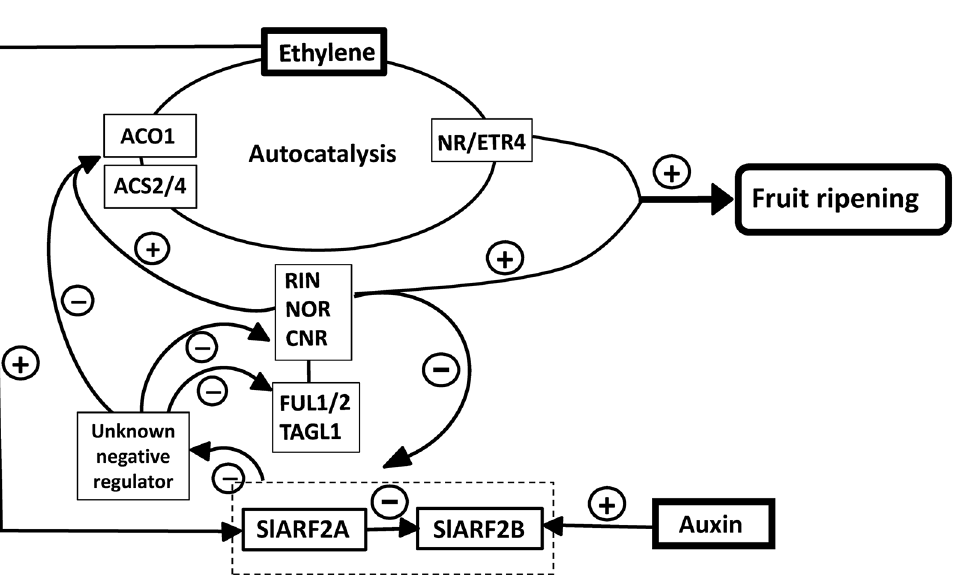
Fig 13. A synthetic model positioning SlARF2 in the regulatory network controlling fruit ripening. SlARF2 mediates tomato fruit ripening by positively regulating key ethylene biosynthesis genes ( ACO1 , ACS2/4 ) and through modulating key regulators of fruit ripening such as RIN, NOR, and CNR transcription factors known to affect ripening by positively regulating ACO1 and ACS2/4 . SlARF2A is up-regulated by ethylene while SlARF2B is up-regulated by auxin. SlARF2A negatively regulates the expression of SlARF2B, thus down-regulation of SlARF2A is compensated by an up-regulation of SlARF2B. SlARF2 also modulates the expression of FUL1/2 and TAGL1 . It is postulated that SlARF2 negatively regulates at the transcription or at the protein level an unknown factor that acts as a ripening repressor.